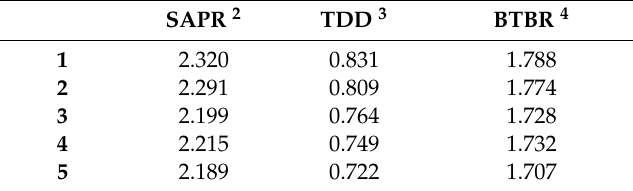
Table 1. Selected bond distances 1 (Å) for 1 – 5 .